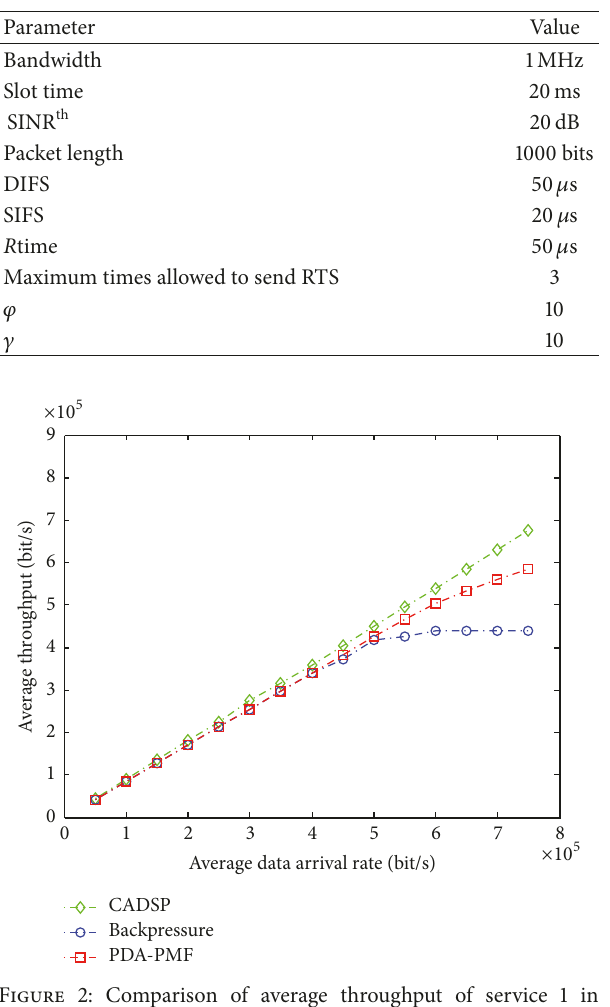
Table 1: Simulation parameters.